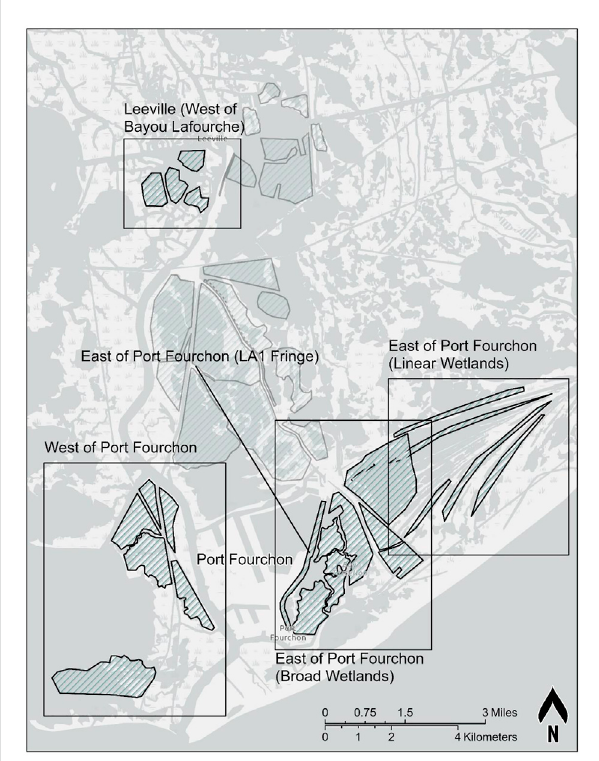
FIGURE 2 Groupings of potential natural and nature-based solutions identi fi ed by the ECG and assessed during stakeholder